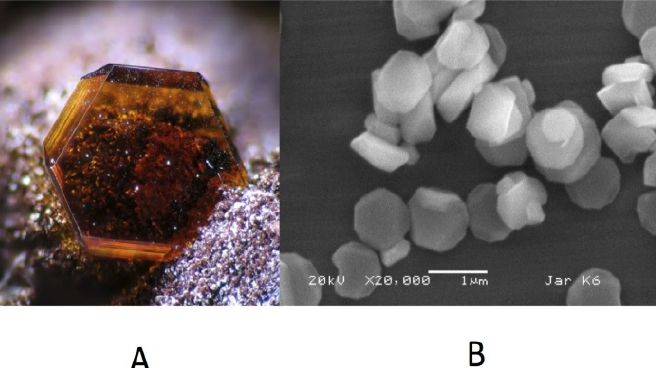
Figure 1. ( A ). A natural crystal of jarosite-type compound [6], and ( B ). Crystals of potassium jarosite obtained with the synthetic method described in this work [7].